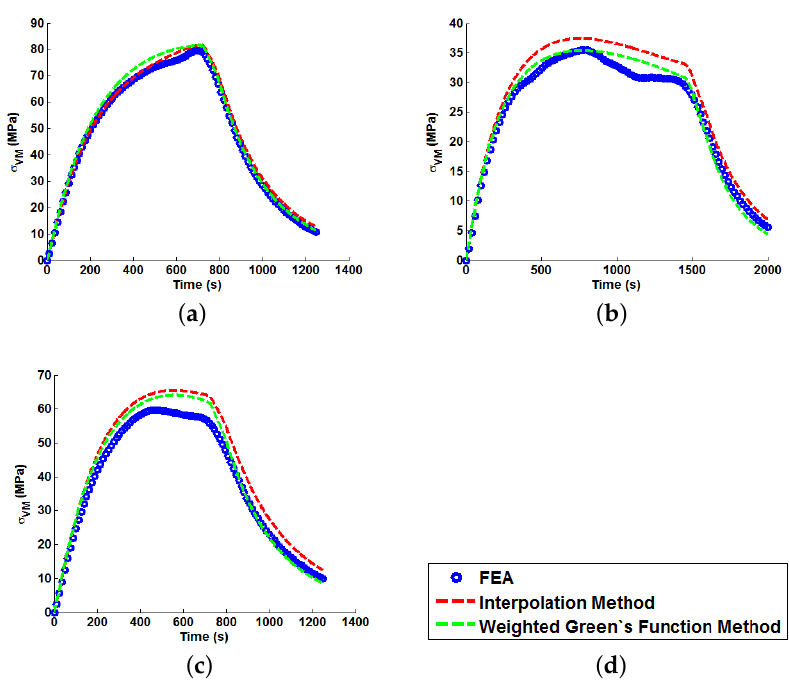
Figure 12. Predictions of thermal stress responses determined using the interpolation and weighted Green’s functions methods for: ( a ) ramp up Profile D; ( b ) ramp up Profile E; and ( c ) ramp up Profile F. Sub figure ( d ) shows the legend used in the plots.